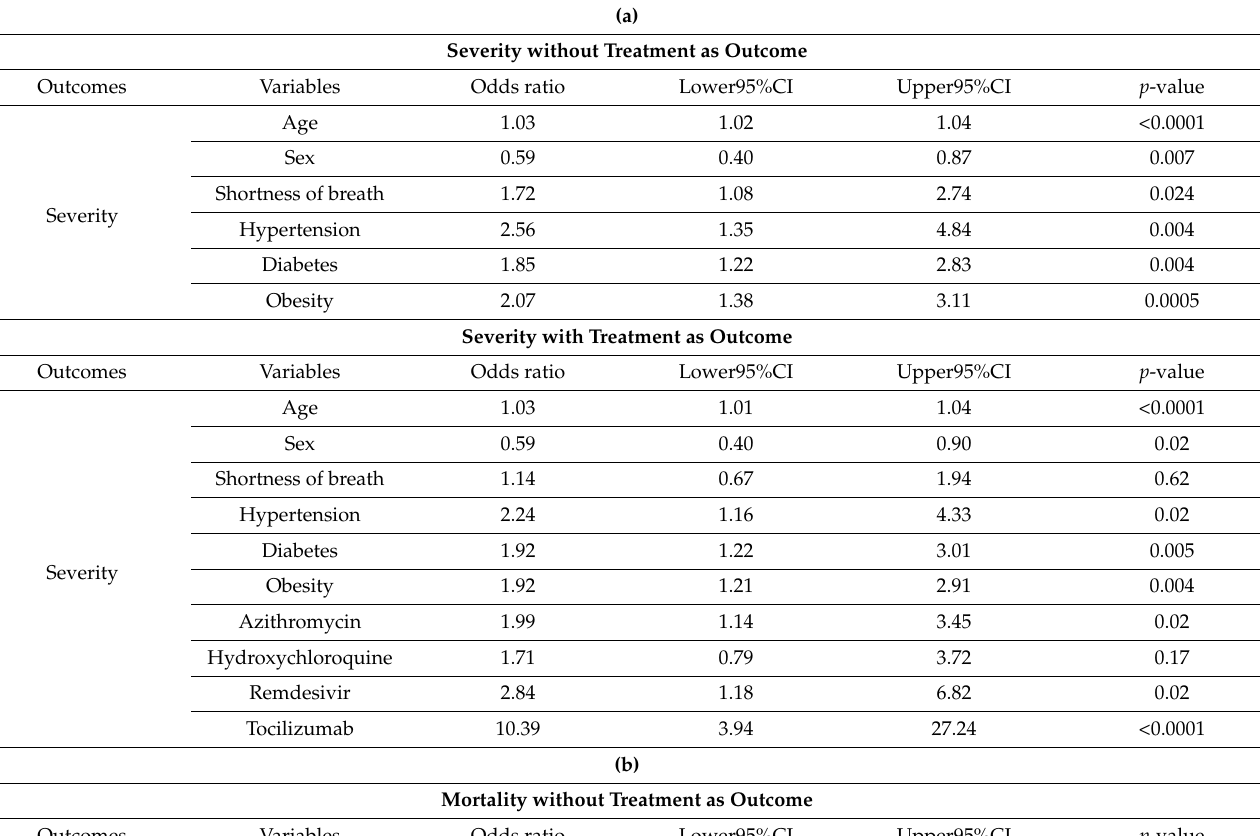
Table 4. (a) Effects of baseline characteristics on the severity of COVID-19 without and with treatment using multivariable logistic regression. (b) Effects of baseline characteristics on mortality of COVID-19 without and with treatment using multivariable logistic regression.